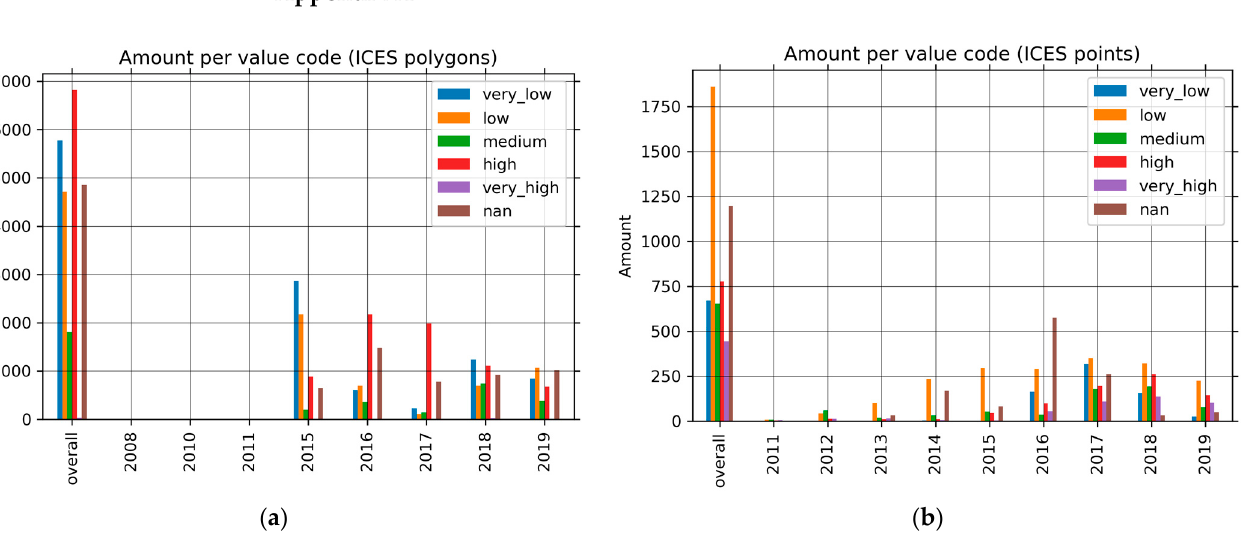
Figure A1. ( a ) Value code per year within ICES polygons dataset; ( b ) Value code per year within ICES points dataset.